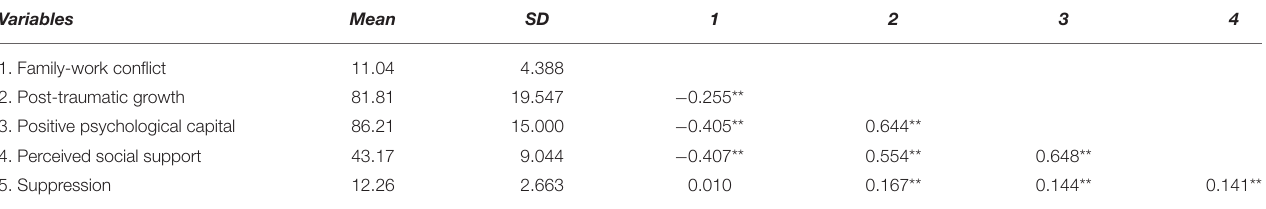
TABLE 1 | Means, standard deviations, and correlation matrix among all variables. Variables